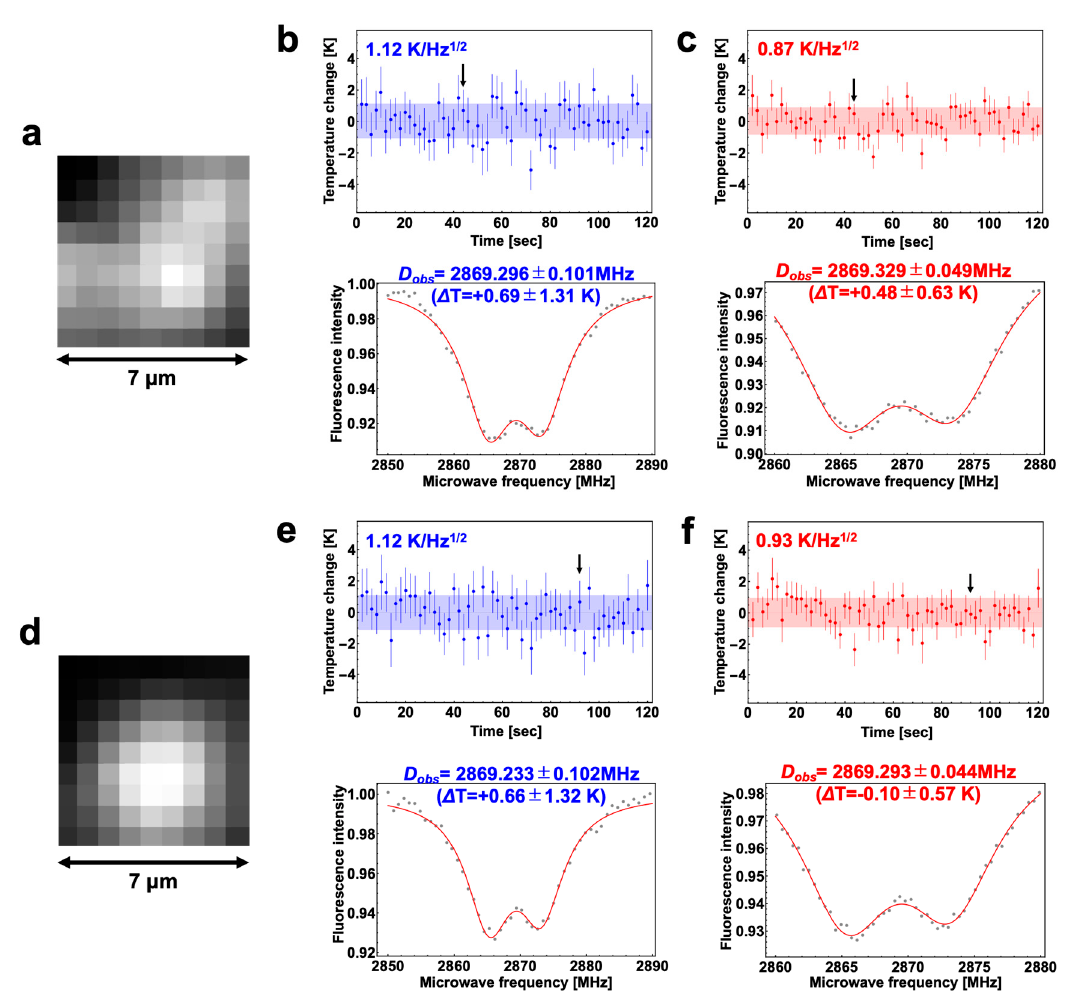
Figure 3. Two typical results of the temperature determination accuracy evaluation at the bright spots A and B are shown in Figure 2a. Fluorescence images ( a and d ), the time courses of the temperature changes (top panels in b , c and e , f ), and typical ODMR spectra (bottom panels in b , c and e , f ) of A and B are shown. The sweep time of each of spectra was 1 s. The typical spectrum was obtained at the time indicated by the black arrows in the corresponding top panels. The accuracies evaluated by fitting errors are shown in the upper left of the top panels. ∆ T is the temperature change and the determination error at a measurement point of time, which were evaluated based on D obs and the fitting error in the determination of D obs , respectively.